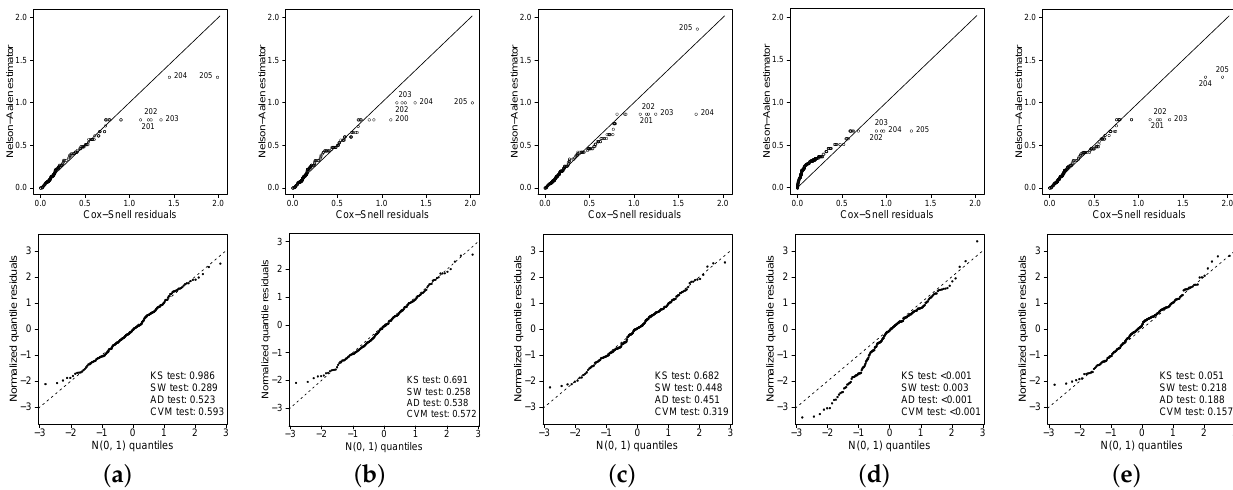
Figure 3. Cox-Snell residuals (upper panels) and normalized quantile residuals plots (lower panels): ( a ) Bellcr, ( b ) Pocr, ( c ) Locr, ( d ) NBcr and ( e ) Geocr models. Table 6. Parameter estimates, standard errors (SE) and maximum value of the log-likelihood function different